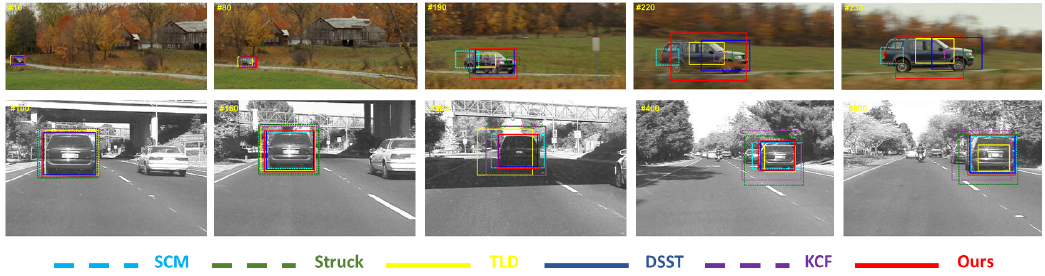
Figure 5. Screenshots of some tracking results in scale variation sequences. These frames are extracted from sequences carscale and car4 , from top to bottom.